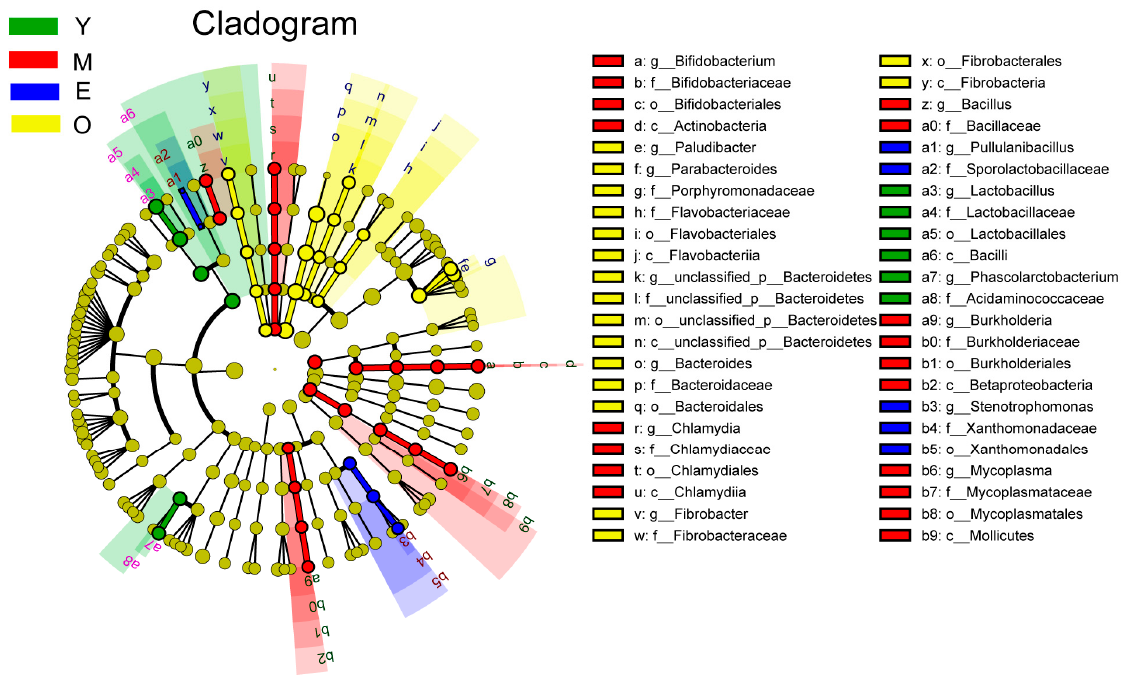
Figure 1. The dairy buffalo rumen bacteria showing different abundance values among four groups (highlighted by small circles and by shading). There are five layers from the inside of this plot to the outside, corresponding to five levels of taxonomy (phylum, class, order, family, and genus). The nodes (small circle) with different colors represent bacterial characteristics of the corresponding groups with a higher relative abundance compared with that in the other three groups, while yellow nodes indicate the bacteria that are not statistically and biologically differentially abundant among the four groups. Significant differences were confirmed by linear discriminant analysis effect size (LEfSe) analysis with the cutoff of LDA > 2.5 and p < 0.05.